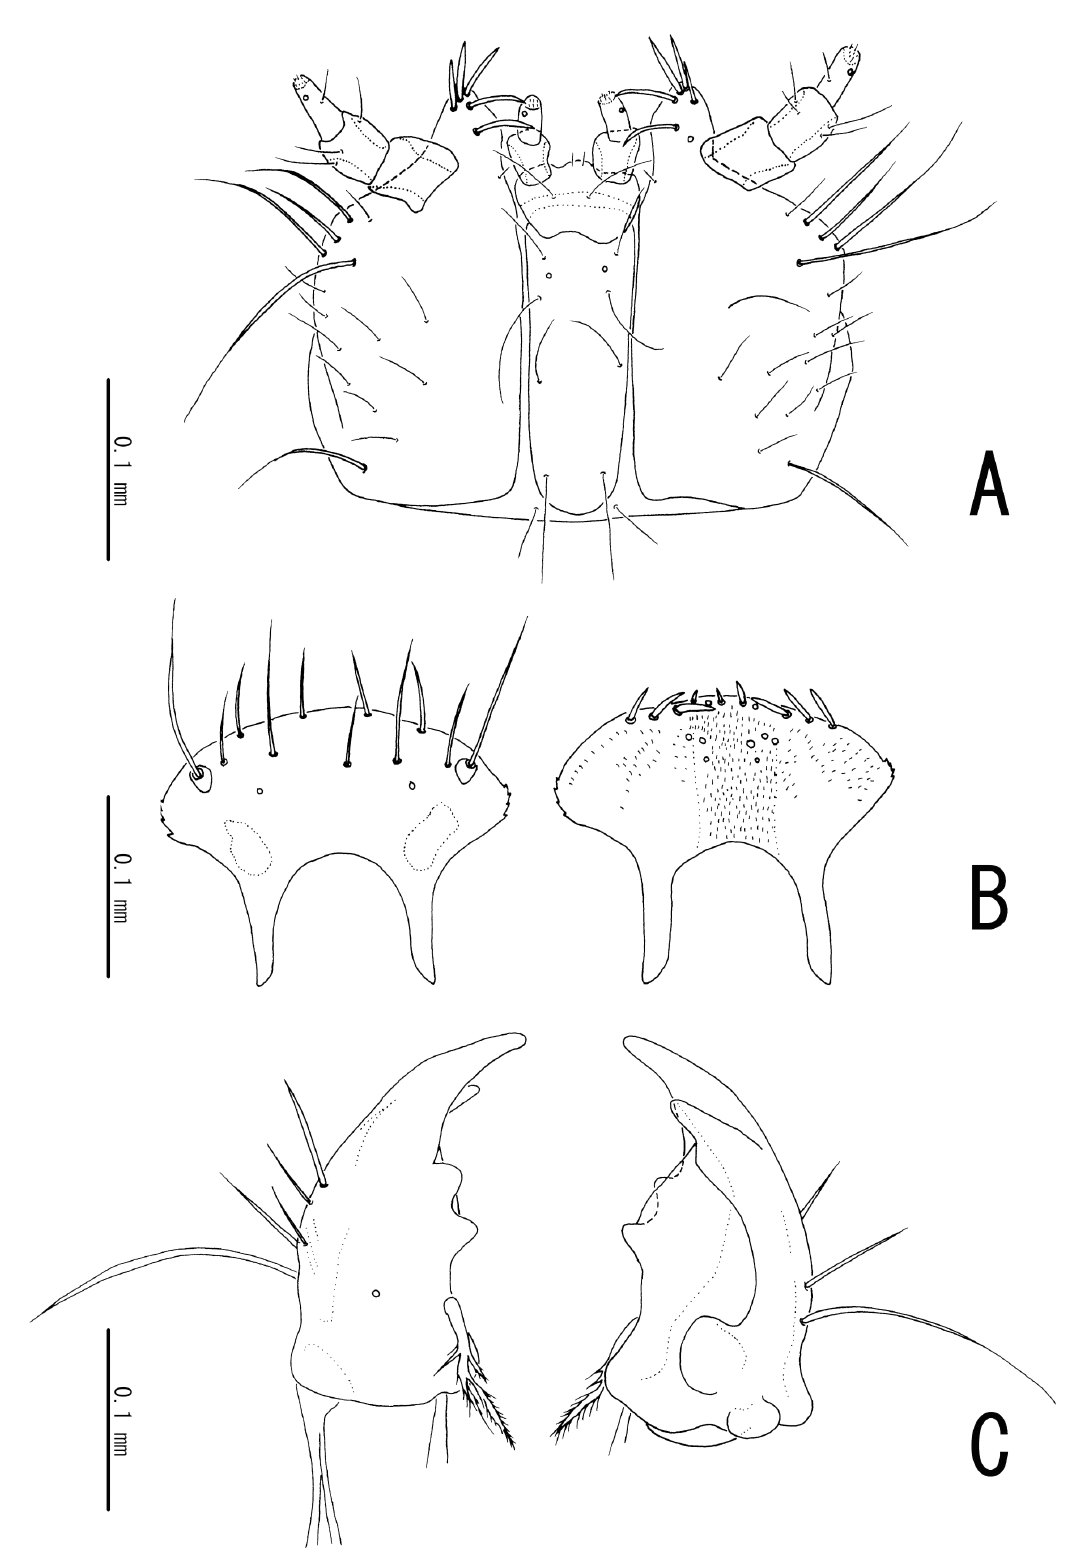
Fig. 11. Larva of Laius rodriguesensis sp. nov. A . Maxillae and labium in ventral view. B . Labrum in dorsal (left) and ventral (right) views. C . Mandible in dorsal (left) and ventral (right)